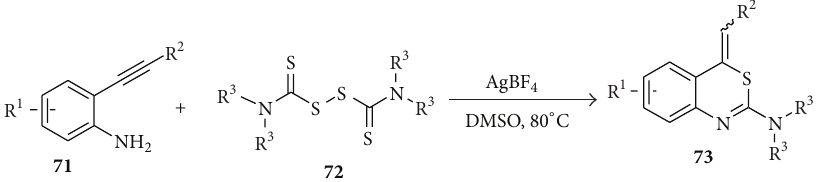
Scheme 13: Synthesis of 4-methylene-4 H- benzo[ d